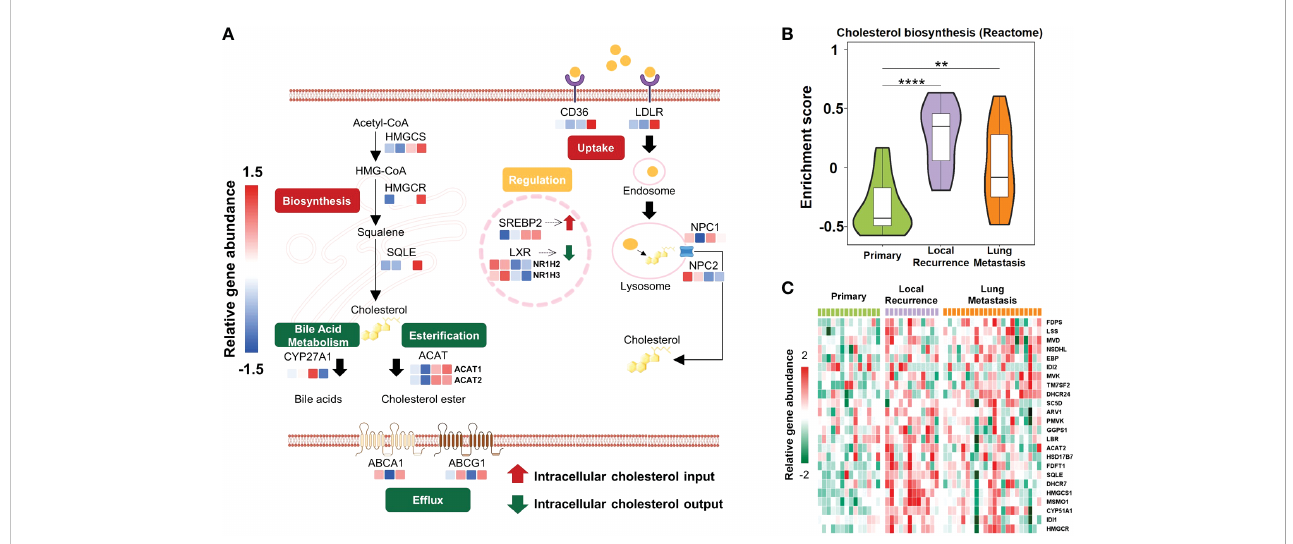
FIGURE 3 Schematic diagram showing active cholesterol metabolism in patients with unfavorable outcomes. (A) Mechanisms regulating cholesterol homeostasis in different subtypes, including repletion (biosynthesis, uptake) and depletion (esteri fi cation, bile acid metabolism, ef fl ux). De novo biosynthesis pathway started from acetyl-CoA and HMG-CoA and stepwise provided squalene for cholesterol synthesis. This process was mediated by rate-limiting enzymes HMGCR and squalene epoxidase (SQLE). Besides biosynthesis, cells also acquire cholesterol from low-density lipoprotein (LDL) uptake via LDLR- mediated endocytosis. Excessive cholesterol was utilized as a precursor to generating bile acids by CYP27A1 or was esteri fi ed by acyl-coenzyme A: cholesterol acyltransferases (ACATs; also known as SOATs). Furthermore, cholesterol ef fl ux was regulated by ATP-binding cassette (ABC) transporters such as ABCA1 and ABCG1. In the nucleus, sterol regulatory element binding protein 2 (SREBP2) and liver X receptor (LXR) were two transcription factors that reciprocally regulated cholesterol metabolism. Colored rectangles from left to right represent S-I, S-II, S-III, and S-IV subtypes in the same row. The color of each rectangle showed Z -score (log 2 of relative abundance scaled by genes ’ SD) of the gene in that sample; red showed high expression while blue showed low. (B) Violin plots exhibited the various enrichment of cholesterol biosynthesis pathways between relapsed or metastatic lesions and primary lesions. The width of the violin plot represented the number of samples at the given enrichment score on the height. Data were derived from the cohort from European Genome-phenome Archive (EGA cohort). **P<0.01, ****P<0.0001 by Wilcoxon-test. (C) Heatmap depicted proteins involved in cholesterol biosynthesis pathways (rows) with the expression level of that sample type in the EGA cohort (columns). Red indicated the high expression; green showed the